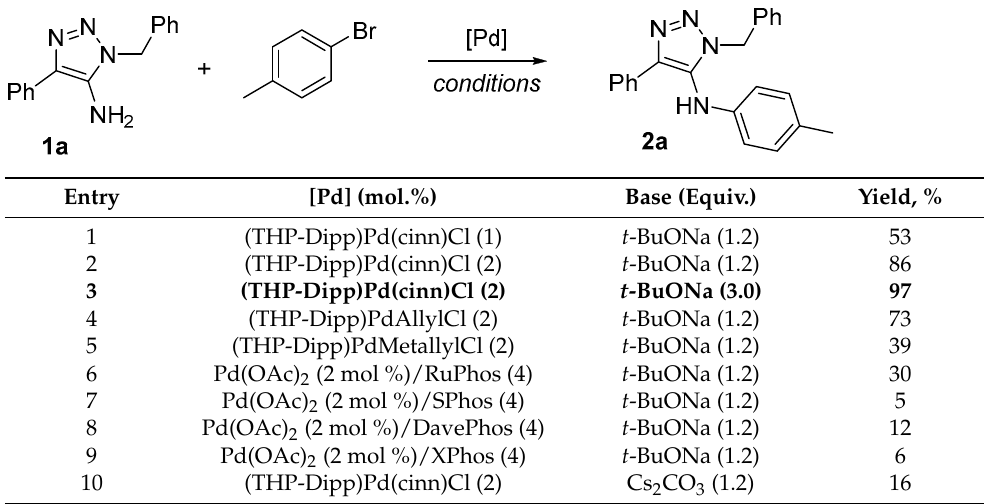
Table 1. Screening of catalytic systems in the BHA reaction 1 .